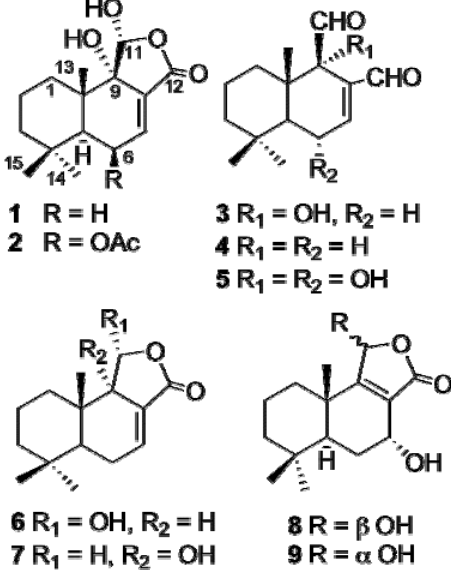
Figure 1. Structures of compounds 1 - 9 .